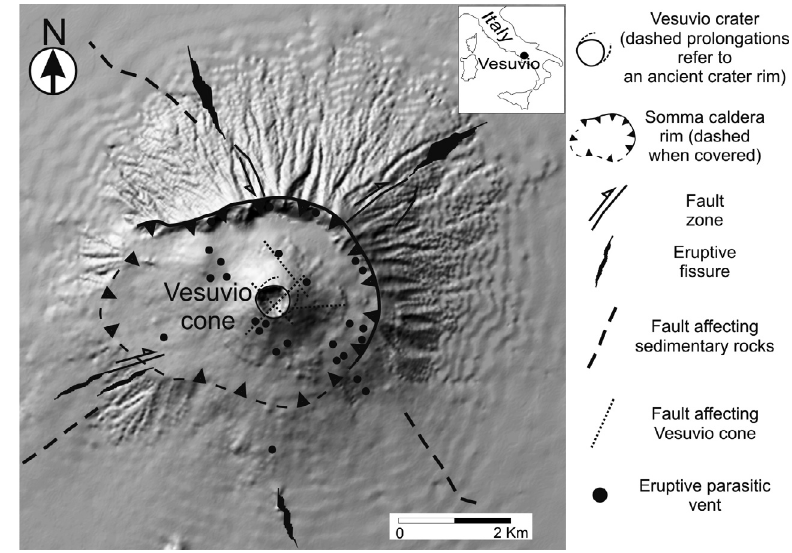
Figure 2. Structural sketch map of Somma-Vesuvio (modified from Bianco et al. [1998] and Ventura et al.